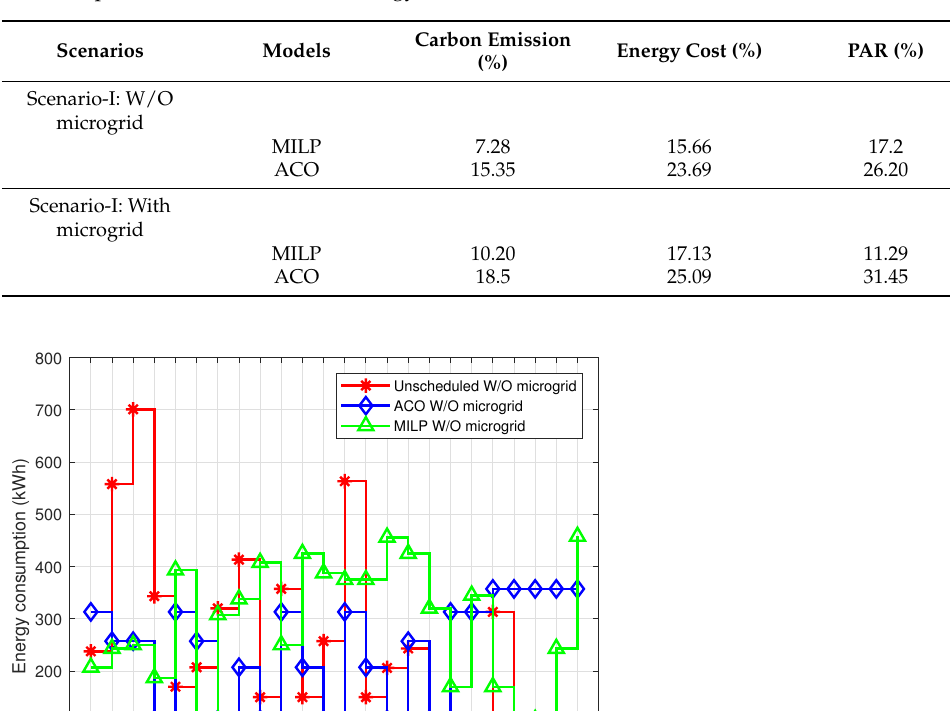
Table 3. Overall evaluation of the developed ACO algorithm compared to MILP and W/O scheduling case in aspects of carbon emission, energy cost, and PAR.